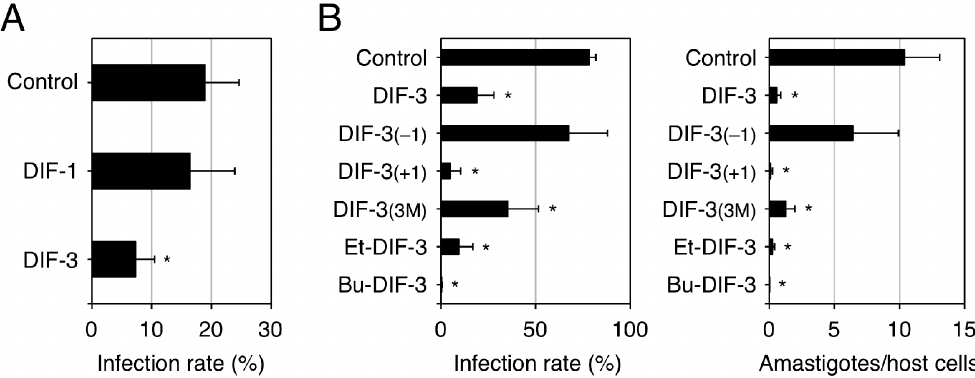
Figure 8. Effects of DIFs on the infection and growth of Trypanosoma cruzi in HT1080 cells. Trypanosoma cruzi ( A : 1 × 10 5 cells/well, B : 5 × 10 6 cells/well) were incubated at 37 °C for 3 days in vitro with human fibrosarcoma HT1080 cells (host cells) in the presence of 0.1% EtOH (vehicle: Control) or 10 μ M of one of the DIF derivatives. Then, the infection rate (parasite ‐ infected HT1080 cells/total HT1080 cells) ( A , B ) and the number of amastigotes (intracellular form of T. cruzi ) in the HT1080 cells ( B ) were assessed microscopically [94]. The means and SD (bars) of three independent experiments are shown (adapted from Nakajima ‐ Shimada et al. [94]). * p < 0.05 versus Control (by t ‐ test; two ‐ tailed, unpaired). DIF ‐ 3 and some of its derivatives strongly suppressed T. cruzi infection and growth in the host cells.